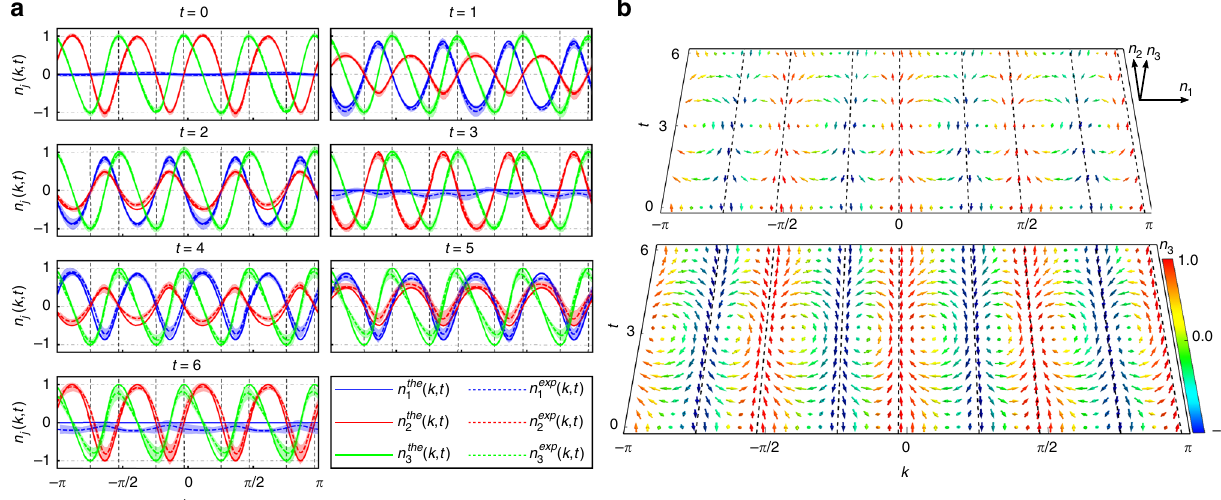
Fig. 5 Experimental results of the PT -symmetry-unbroken QW dynamics with a large winding-number difference. a Time-evolution and b spin textures of n ( k , t ) in momentum – time space for a quench process between the initial non-unitary Floquet operator given by ð θ i (cid:9) (cid:10)(cid:9) (cid:10) π ¼ π = 2 ; θ f ¼ (cid:3) arcsin 1 the fi nal one characterized by θ f with ν f = 2. The eight fi xed points (dashed lines) are located at { − 0.5300 π , − 0.0300 π , α cos 1 2 6 0.4699 π , 0.9699 π } for c − = 0; and { − 0.7450 π , − 0.2450 π , 0.2550 π , 0.7550 π } for c + = 0. The color code represents the value of n 3 ( k , t